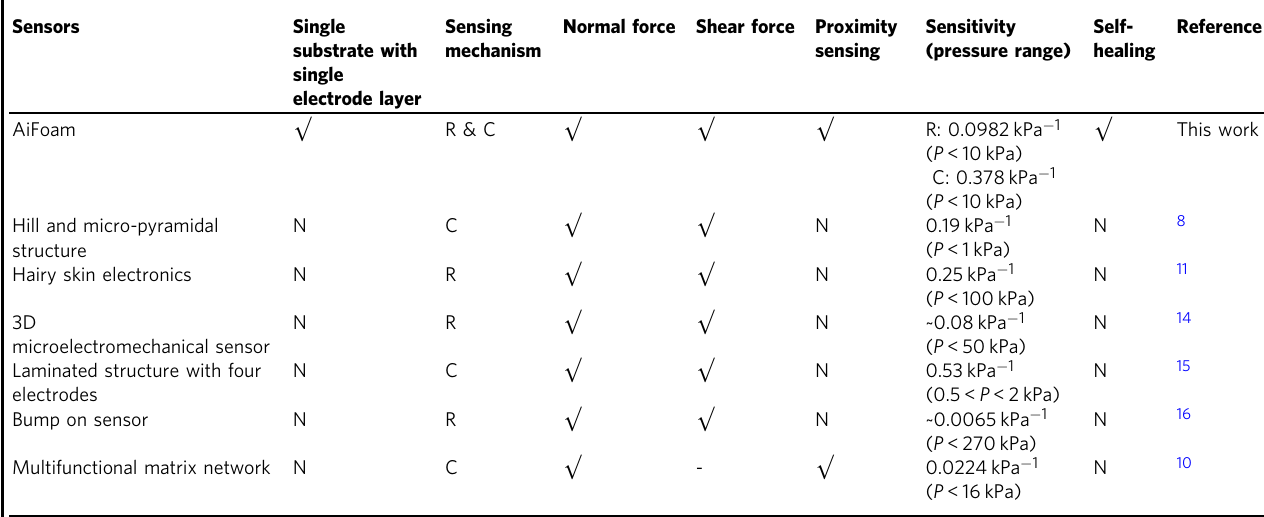
Table 1 Comparison of different tactile sensor skins.